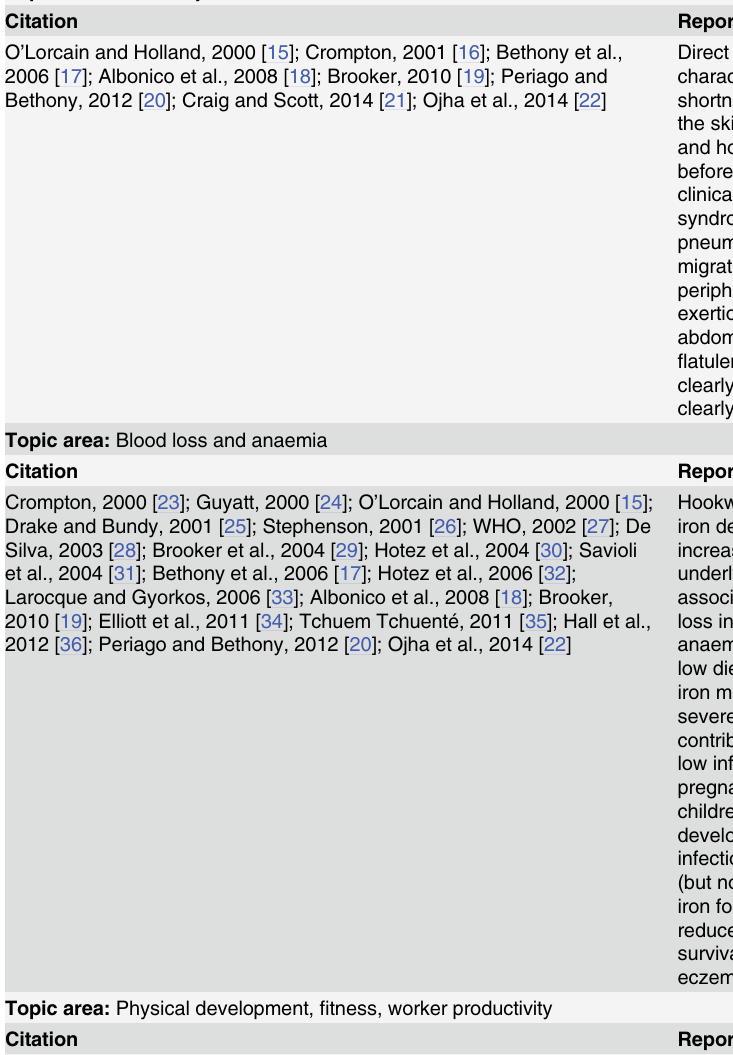
Table 1. Summary of existing evidence from narrative reviews of soil-transmitted helminth morbidity published since 2000. Topic area: STH entry and establishment